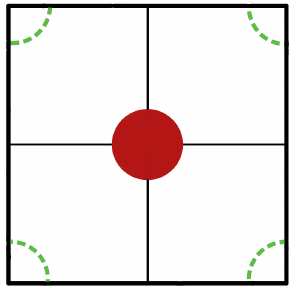
Figure 3: Calculation using SU ( 2 ) × SU ( 2 ) . The figure depicts saddles on ( ω ) plane. The center of the square is at ( 0,0 ) . The corners are at , ω 1 2 ( 1 / 2,1 / 2 ) , ( 1 / 2, − 1 / 2 ) , ( − 1 / 2,1 / 2 ) , ( − 1 / 2,1 / 2 ) . For the bosonic case, all the sad- dles contribute. When we add fermions in the mix, the green colored saddles at ( 0, ± 1 / 2 ) , ( ± 1 / 2,0 ) don’t contribute anymore, leading to an overall factor of 1 / 2. We have drawn circular regions arounds the saddle to denote how much the fluctua- tion around the saddle contributes. For example, each of the corner ones contributes one quarter of the center